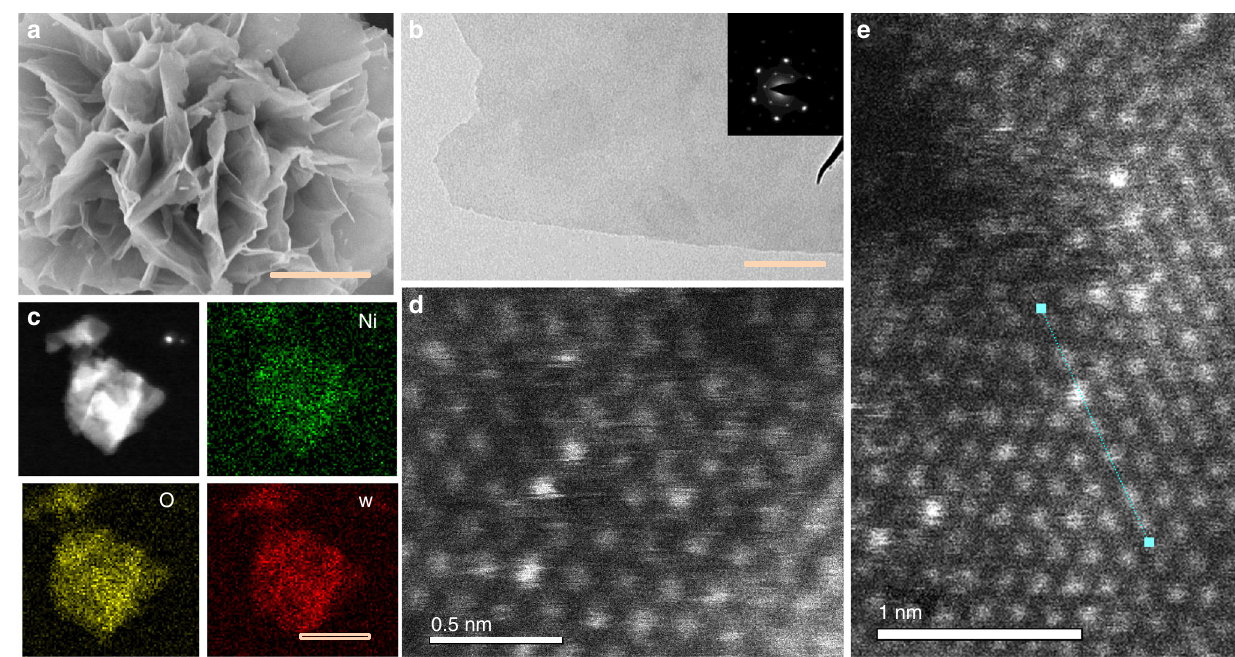
Fig. 3 Electron microscope analysis of the w-Ni(OH) 2 sample. a SEM image, scale bar: 100 nm. b TEM, the inset shows the corresponding electronic diffraction spectra, scale bar: 100 nm. c The HADDF result and the corresponding element mapping, scale bar: 100 nm. d, e HAADF-STEM image, the corresponding element contrast result in e can be found in Supplementary Fig. 9d, the scale bars are 0.5 and 1 nm for d and e ,